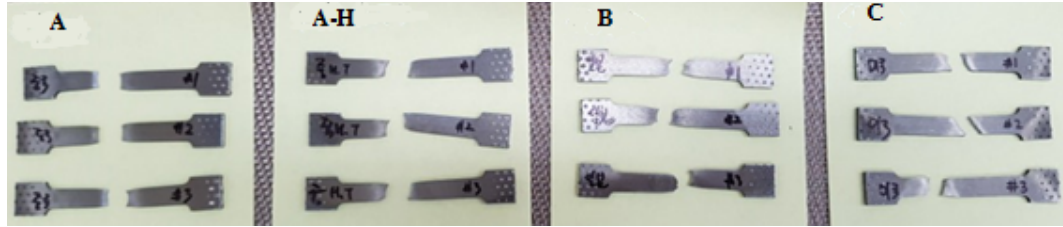
Figure 10. Tensile specimens of different Ti6Al4V samples (A, A-H, B and C) after the tensile test. Table 4. Tensile test